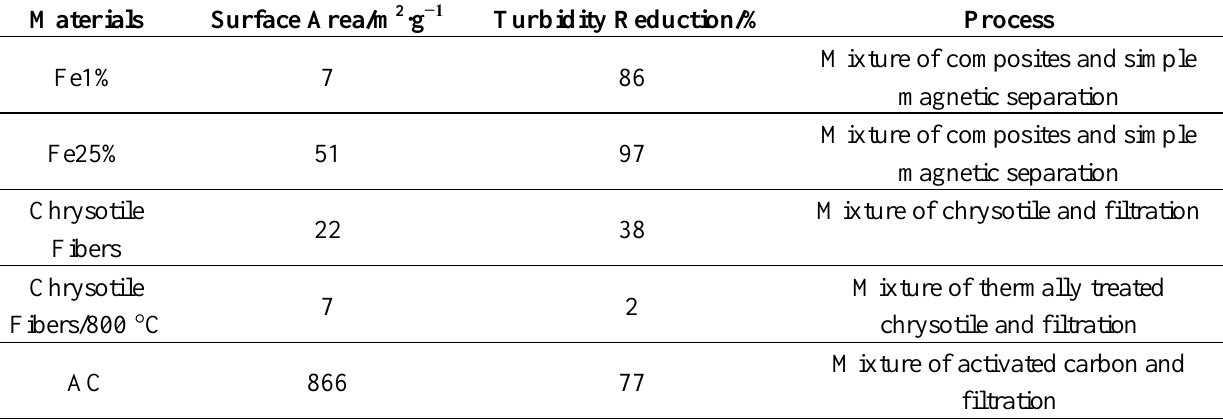
Table 2. Surface area of the materials used and turbidity removal of biodiesel wastewater upon contact and separation with different